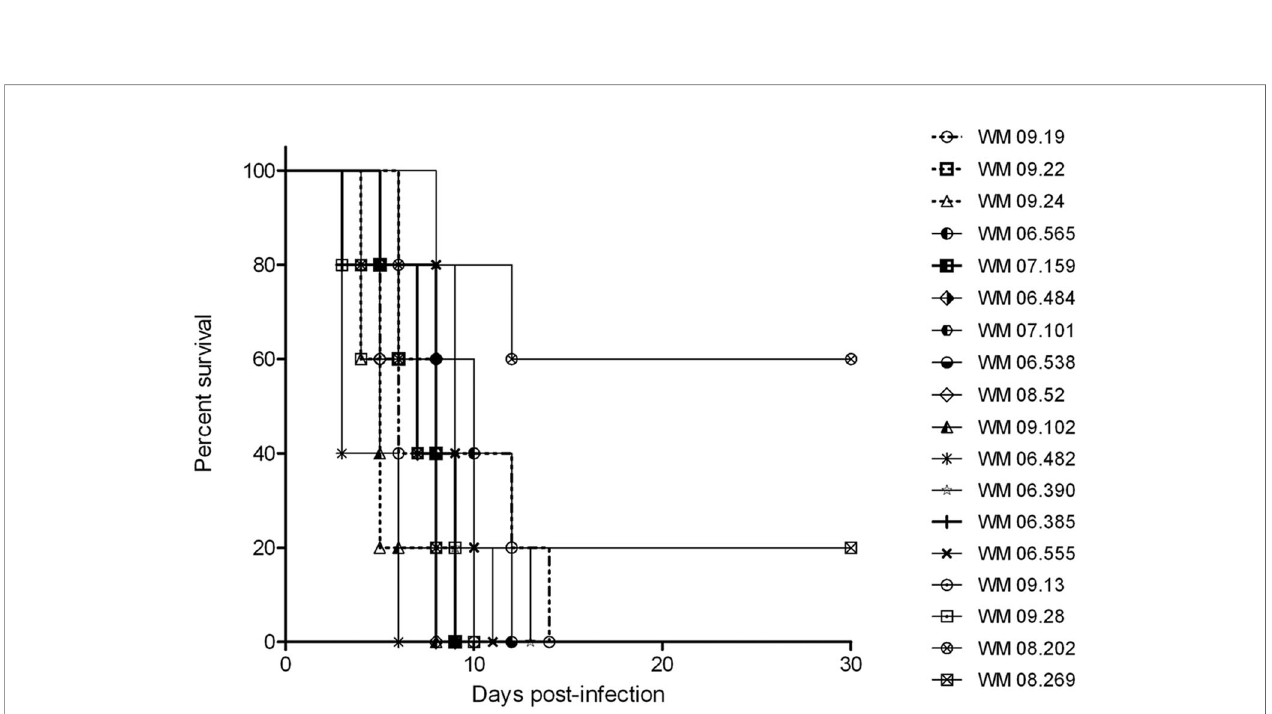
FIGURE 4 | Animal virulence study. Survival plots of mice infected with selected Scedosporium aurantiacum strains. Environmental strains: WM 09.13 WM 09.19, WM 09.22, WM 09.24, and WM 09.28; Invasive clinical strains: WM 06.482, WM 06.538, WM 07.101, WM 08.202; Colonizing clinical strains: WM 06.385, WM 06.390, WM 06.484, WM 06.555, WM 06.565, WM 07.159, WM 08.52; and clinical strains without information on infection status: WM 08.269, WM